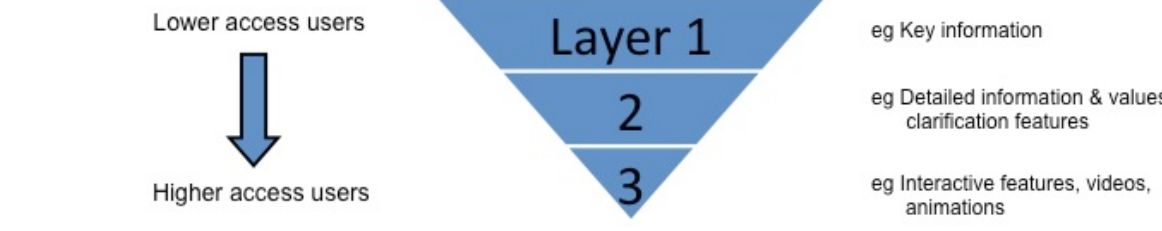
Figure 4. A diagram representing the stratum approach to developing decision